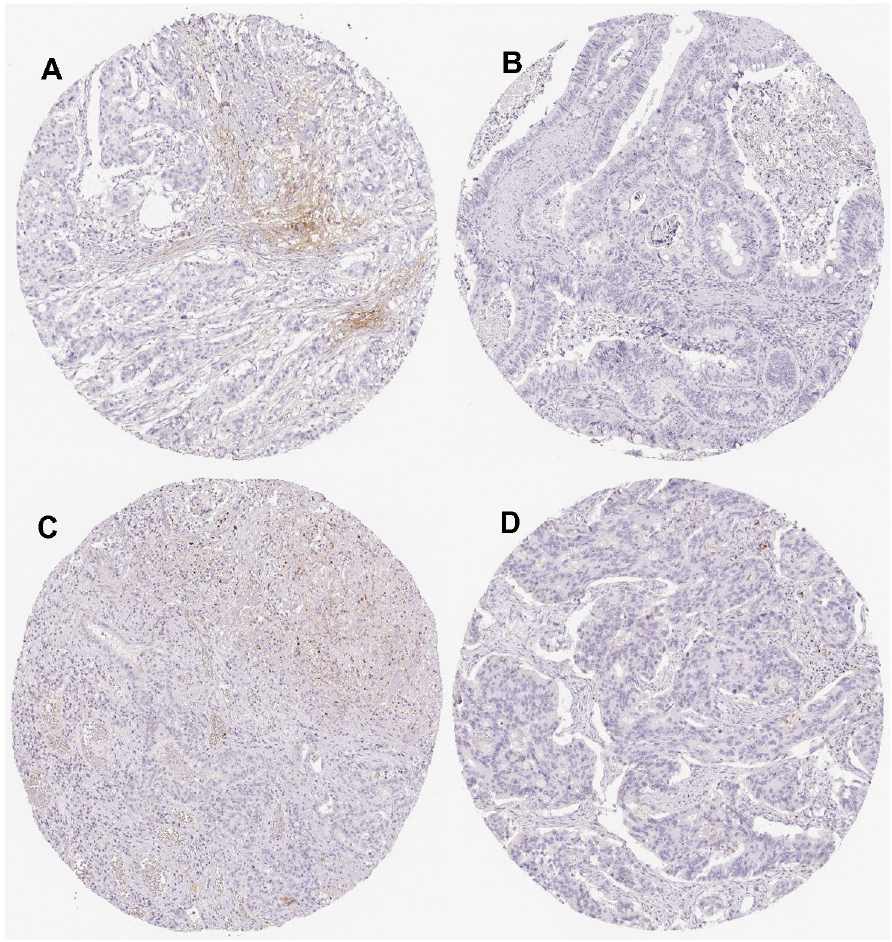
Figure 7. Pathological section images of expression of ITIH2 in CRC were taken from the Human Protein Atlas online database. See Table 6 for gene